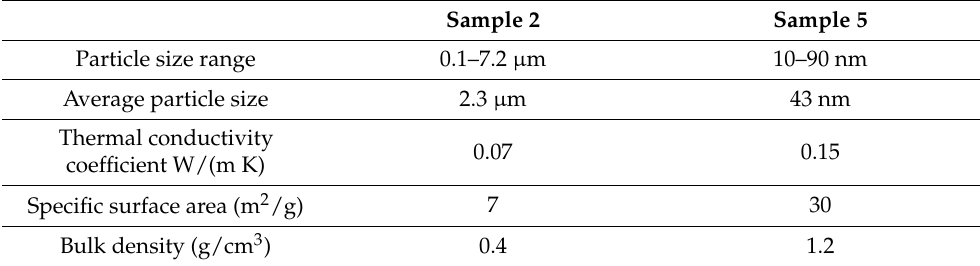
Table 2. Properties of synthesized ZnO powders and anhydrous zinc